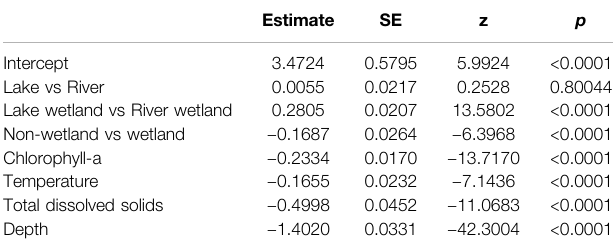
TABLE 4 | Fixed effects from the statistical model of total abundance within Mildred Island, Sacramento-San Joaquin River Delta,